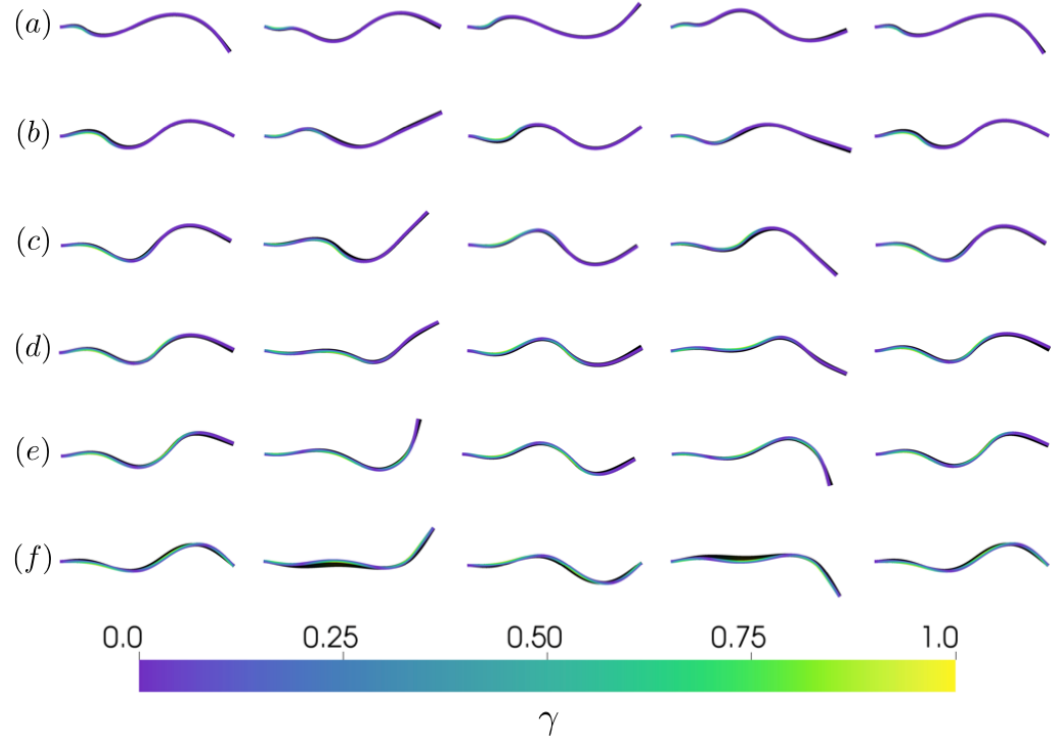
Figure 3. Side profile views at time (from left to right) 9.0, 9.25, 9.5, 9.75, and 10.0 s for A = ( a ) 1 and ( f ) 6 . Tail color indicates the instantaneous strength of contraction ( γ 6